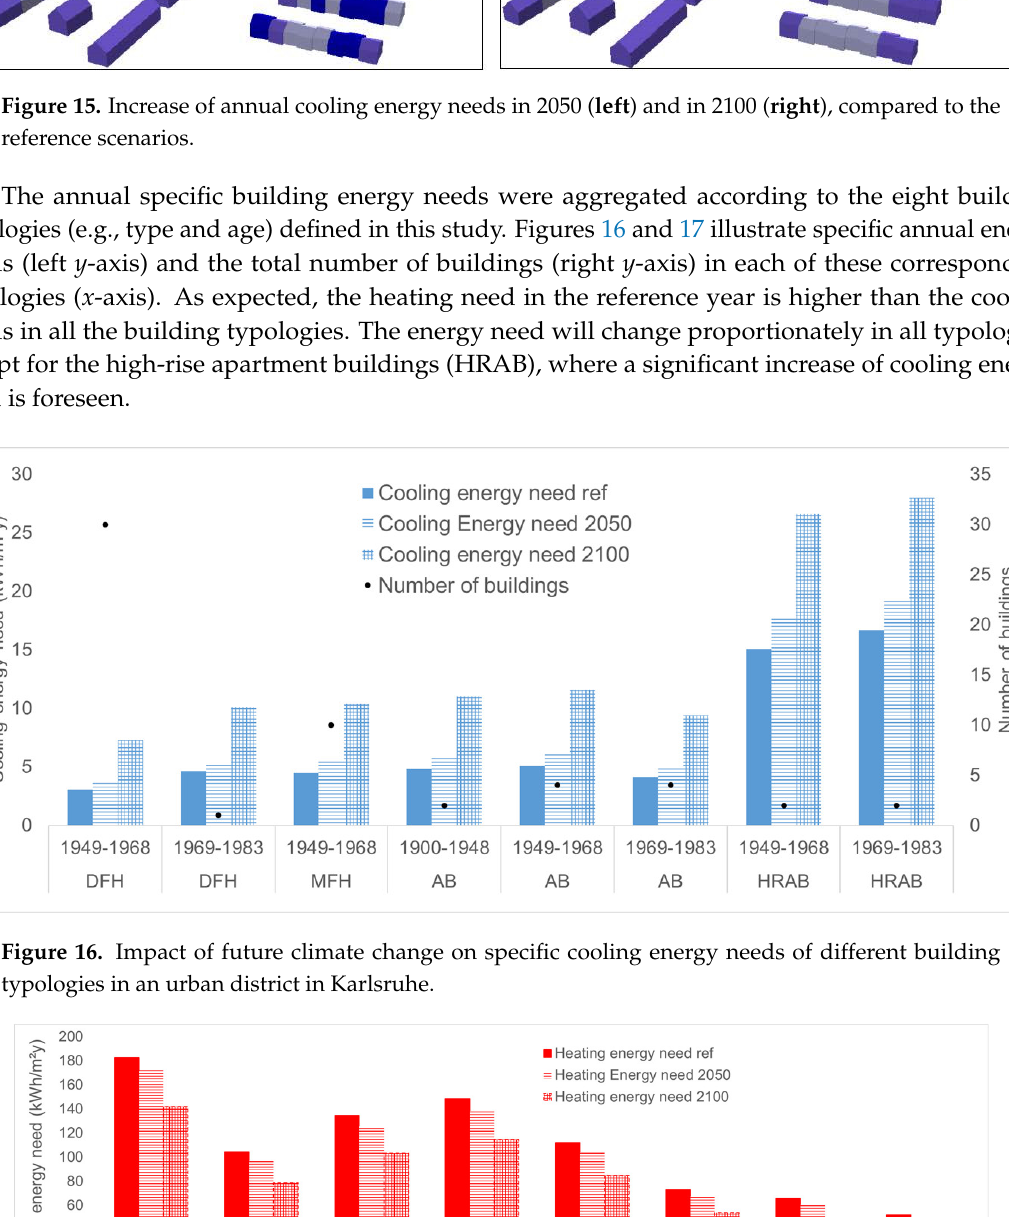
Figure 17. Impact of future climate change on specific heating energy needs of different building typologies in an urban district in Karlsruhe.